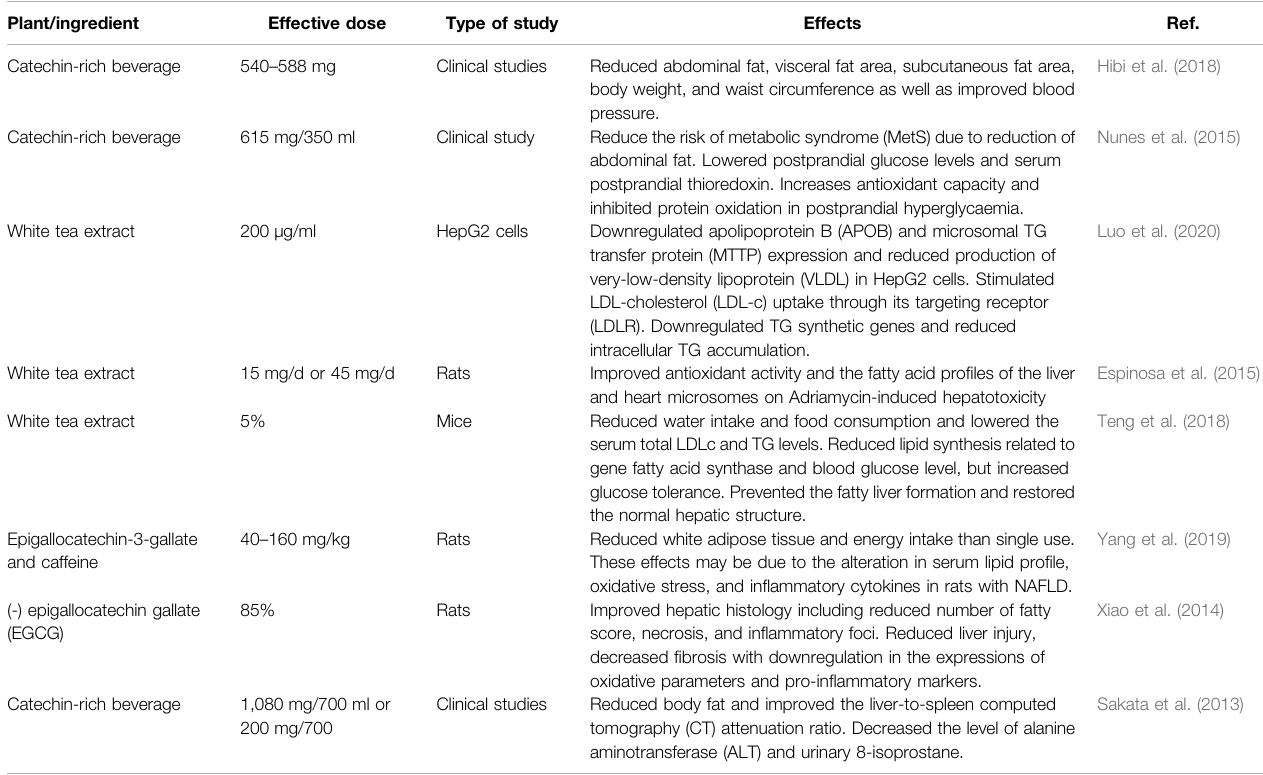
Clinical studies Reduced body fat and improved the liver-to-spleen computed tomography (CT) attenuation ratio. Decreased the level of alanine aminotransferase (ALT) and urinary